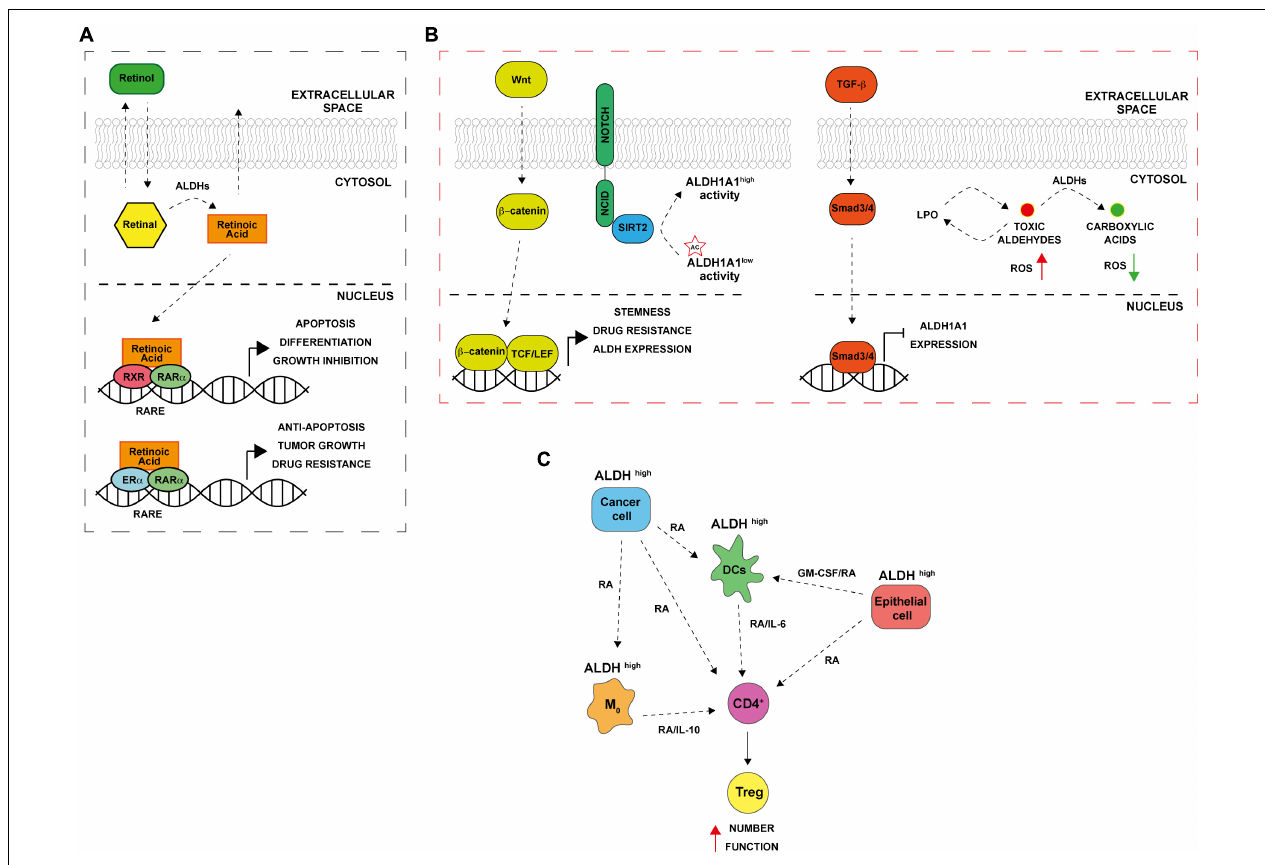
FIGURE 1 | Aldehyde dehydrogenases (ALDHs) functional mechanisms. (A) ALDH in normal and cancer cells. Retinol (vitamin A) absorbed by normal and cancer cells is converted to retinal in the cytosol. ALDH enzymes oxidize retinal to retinoic acid (RA). RA can be secreted and diffused into neighboring cells or translocated into the nucleus where it binds to dimers of the retinoic acid receptor (RAR) and retinoic X receptor (RXR), inducing the expression of its downstream target genes that are involved in differentiation, apoptosis, and growth inhibition. In ER positive cancer cells, alternative RA signaling induces the expression of genes related to cell proliferation, stemness, tumor growth and anti-apoptosis. RARE (retinoic acid response elements). (B) ALDH and CSCs. The Wnt pathway directly regulates ALDH1A1 through β -catenin/TCF-dependent transcription, promoting drug resistance and stemness. TGF- β downregulating ALDH1A1 in Smad4- dependent manner. NOTCH signaling drives ALDH proteins deacetylation by SIRT2. In addition, ALDHs promote the oxidation of toxic reactive aldehydes into less toxic carboxylic acids limiting reactive oxygen species (ROS) production and lipid peroxidation. (C) ALDH and immune tolerance. Cancer cells with high ALDH levels release factors including RA that in turns increase ALDH levels in several cells of the TME including macrophages (M 0 ), dendritic cells (DCs) and normal epithelial cells. The consequent RA production enhances Treg differentiation from CD4 + T cells; increasing their activity thus leading to immune